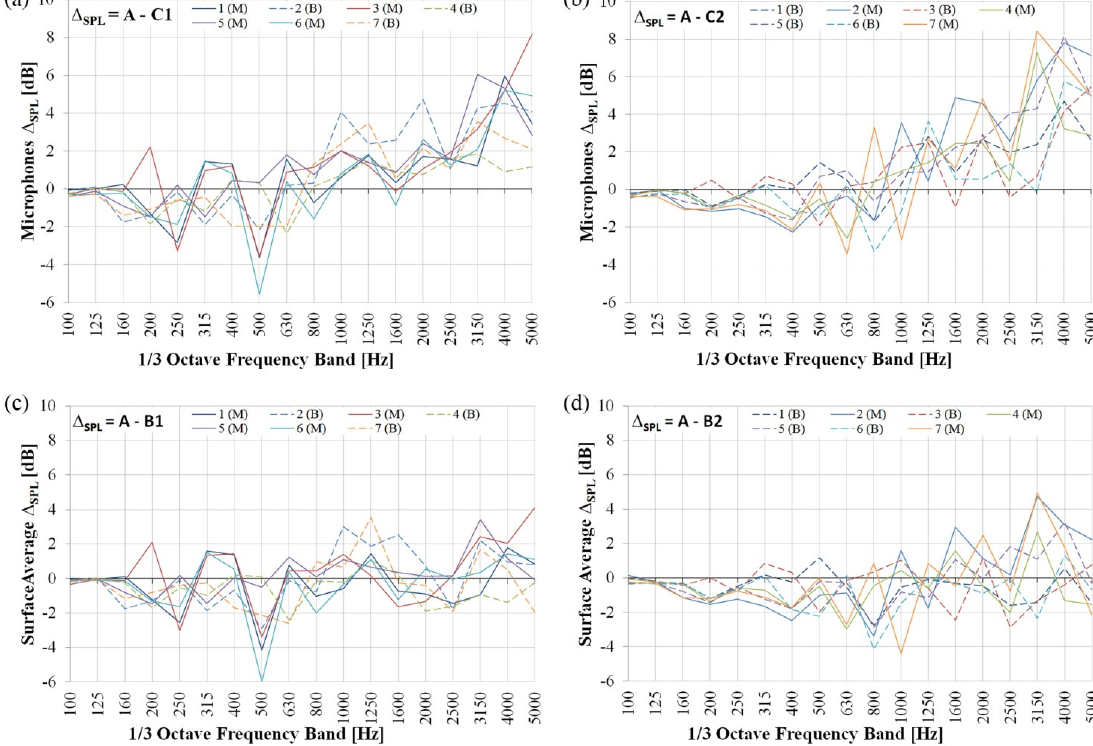
Figure 7. Arithmetic differences of the SPLs measured by each microphone placed over the glass on the third floor. ( a ) Δ SPL = A SPL − B1 SPL ; ( b ) Δ SPL = A SPL − C1 SPL